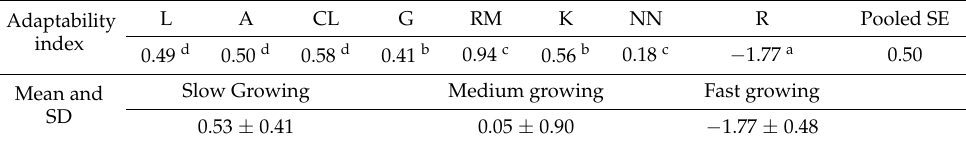
Table 2. Adaptability indexes of different poultry genotype. Modified from